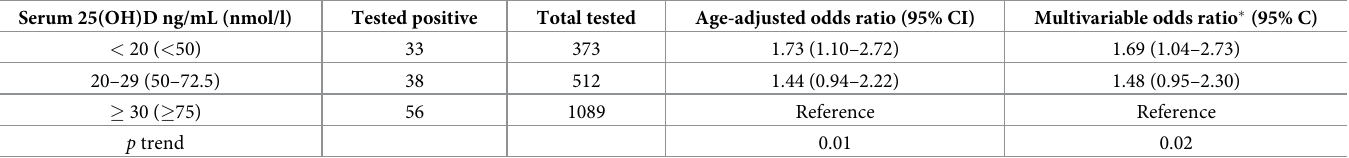
In multivariable models, COVID-19 risk factors of having � 3 people in household (versus one person) and report of unsafe working conditions (versus report of not unsafe) were signifi- cantly associated with increased odds of testing positive (OR 2.14 (95% CI 1.36–3.38) and 1.77 (95% CI 1.08–2.89), respectively) (data not shown). Results of stratified analyses are shown in Table 3. Associations in the overall data were con- sistent across strata of age and neighborhood SES. A stronger association of low 25(OH)D level with COVID-19 test positivity was observed among women with obesity (p trend 0.004), Table 2. Serum 25(OH)D concentrations in relation to COVID-19 infection, among 1,974 Black Women’s Health Study participants who provided a blood sample 3–7 years prior to 2020. Serum 25(OH)D ng/mL